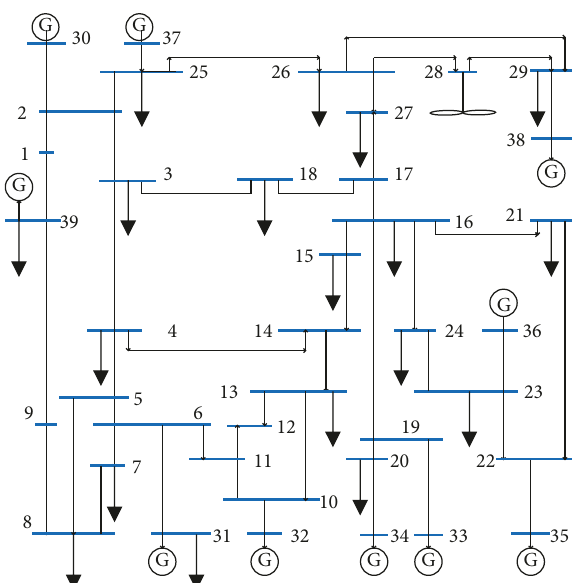
Figure 4: The New England 10 machine 39 node system. Time and voltage C2 controller